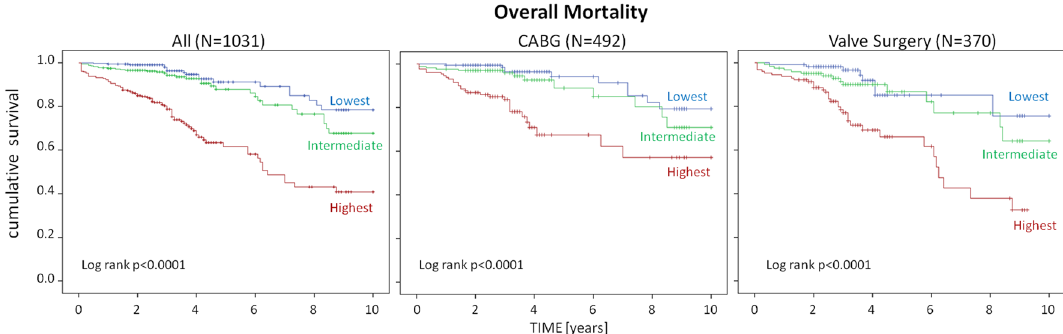
Figure 1. Kaplan–Meier survival curves for overall mortality by tertiles of red blood cell distribution width for the whole patients’ population (left panel) and for the subgroups of patients who underwent coronary artery by-pass alone (CABG, central panel) or valve surgery alone (right panel).